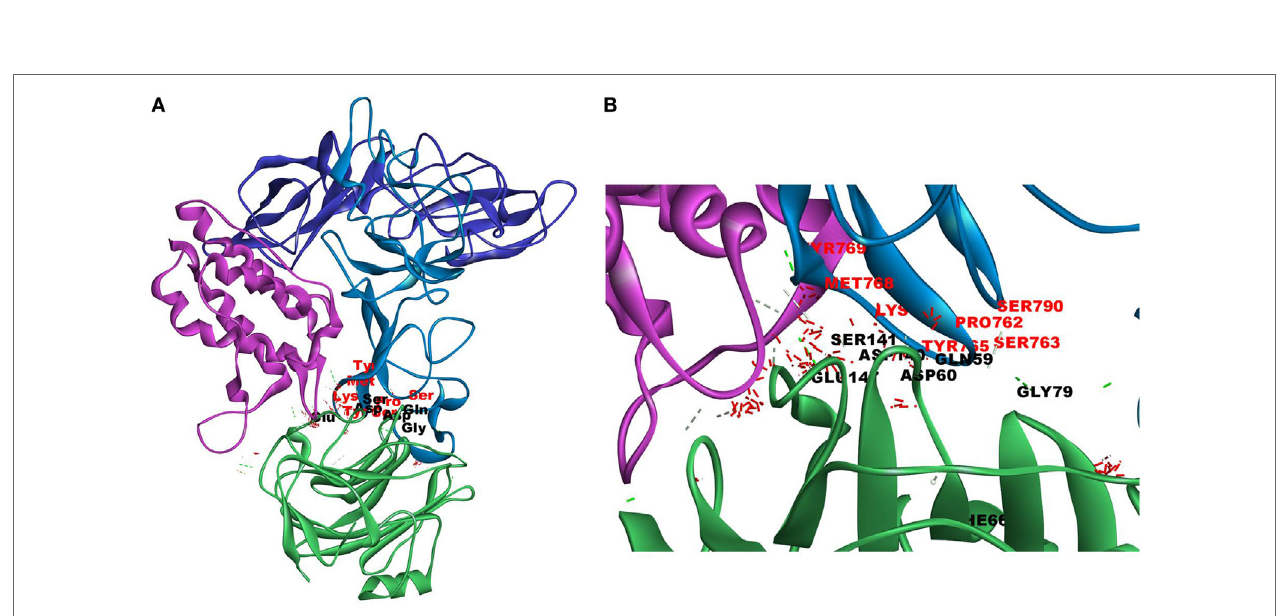
FigUre 4 | Docking of C-reactive protein (CRP) to leptin–leptin receptor complex. Leptin (PDB Id 1AX8) –leptin receptor (CRH2–FNIII) complex was prepared, the complex was energy minimized, prepared for further docking as described in Section “Materials and Methods” and docked with CRP (PDB Id 1GNH). Protein– protein docking was done as described in Figure 1 . The image of the pose with the best Z -rank score in the largest cluster is shown. (a) Leptin (pink) was docked (site specific) to modeled leptin receptor [CRH2 (deep blue)–Fn III (light blue)], CRP monomer (green). (B) Enlarged image of docked amino acid skeleton.